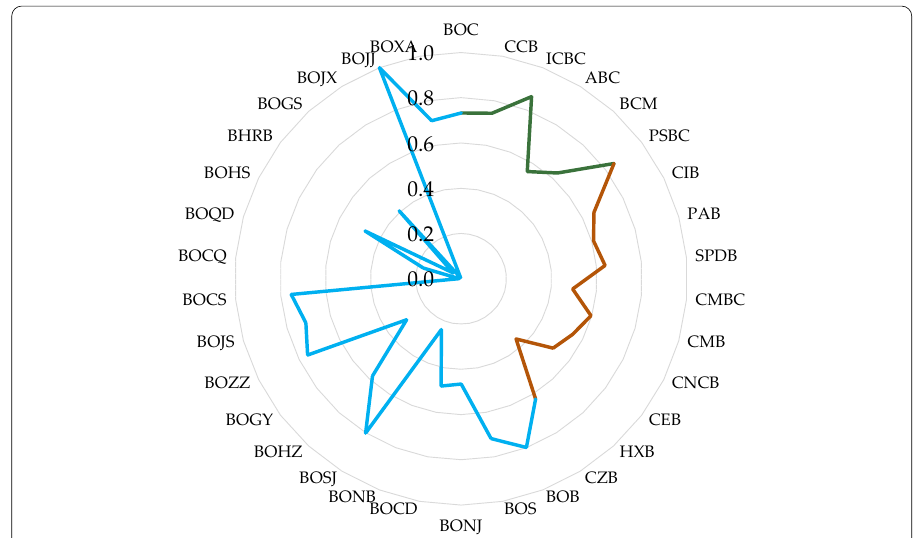
Fig. 3 Overall efficiency for each type of bank from 2012 to 2018 with an exogenous variable